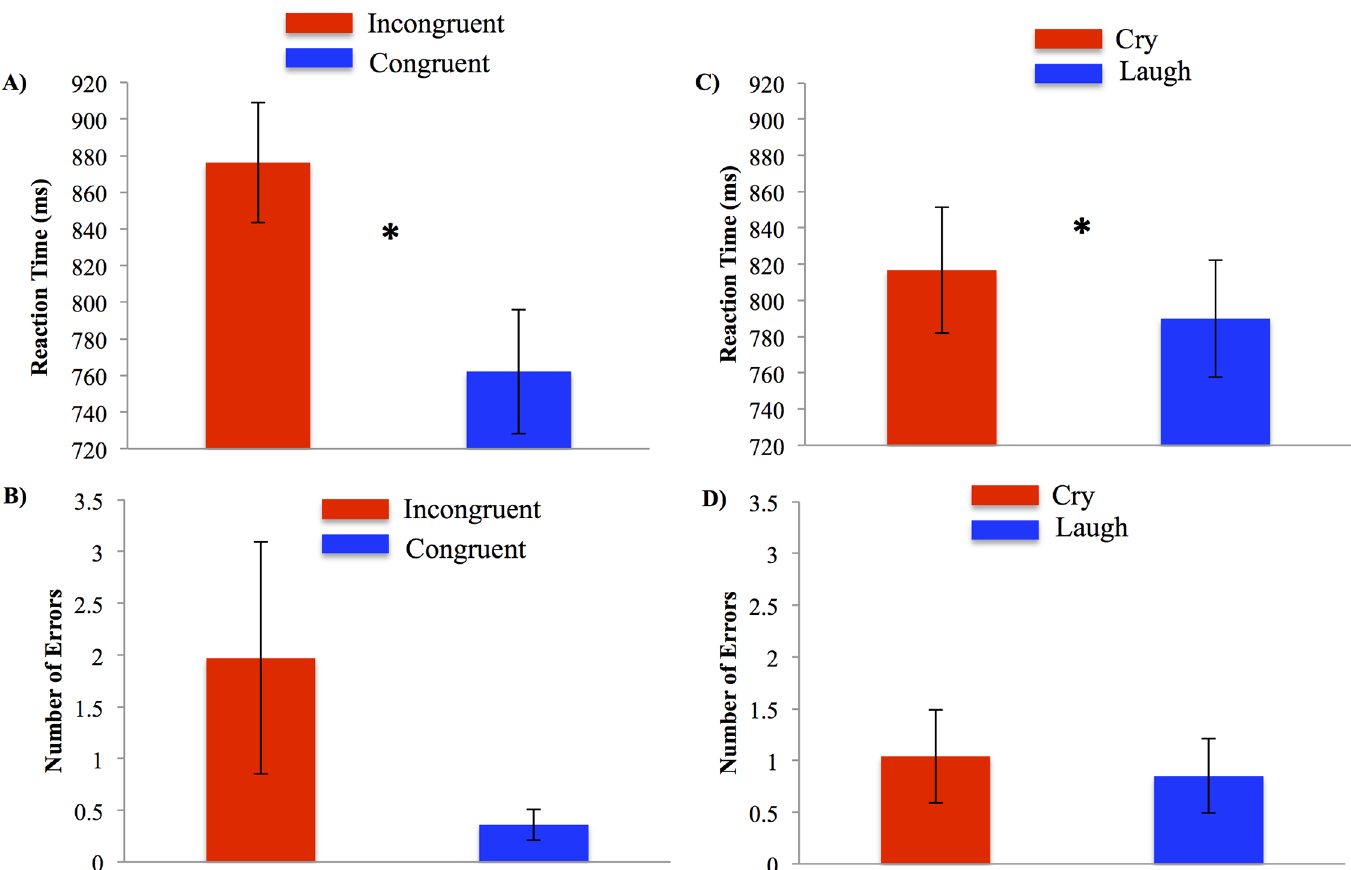
Fig 6. Performance on the simultaneous cross-modal distraction paradigm differed by Stroop condition and valence of infant vocalizations in Experiment 2. (A) Mean reaction time (in milliseconds, ms) and number of errors (B) for incongruent (red bars) and congruent trials (blue bars). Mean reaction time (C) and number of errors (D) for cry (red bars) and laugh (blue bars) conditions. Asterisks ( * ) represent statistical significance at p < .01 value. Error bars represent standard errors.